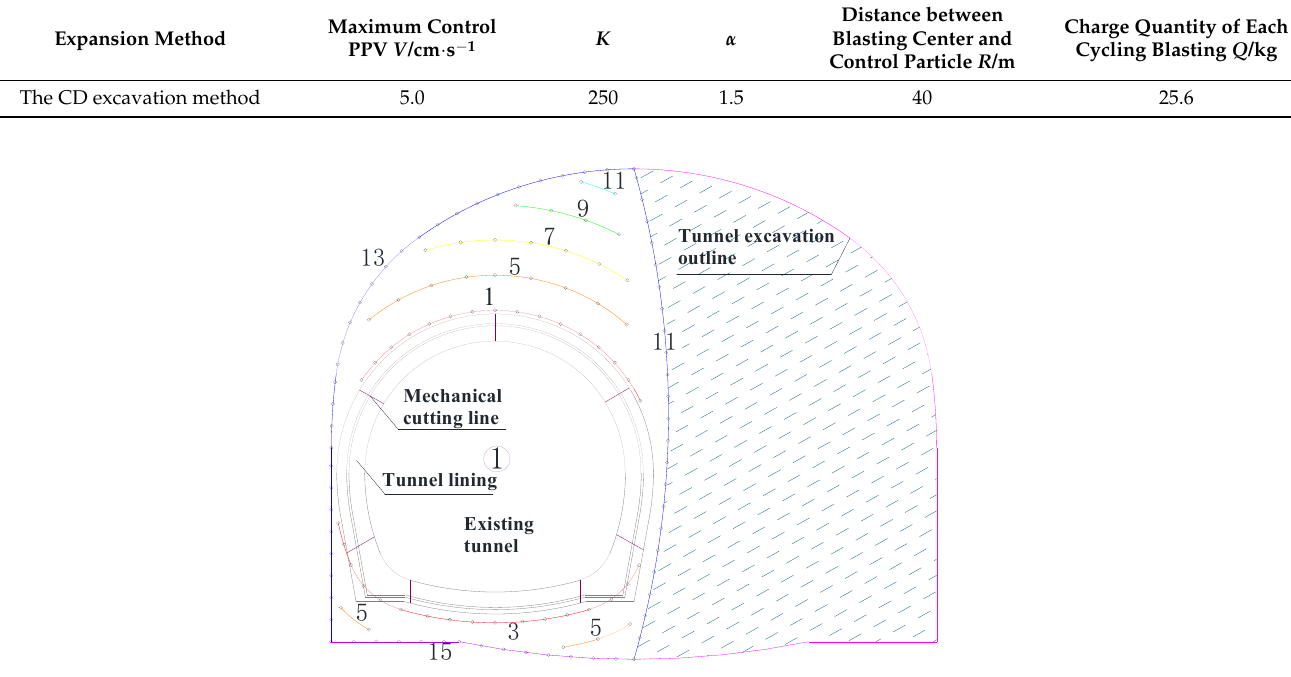
Figure 3. Blast holes of subway station expansion excavation.